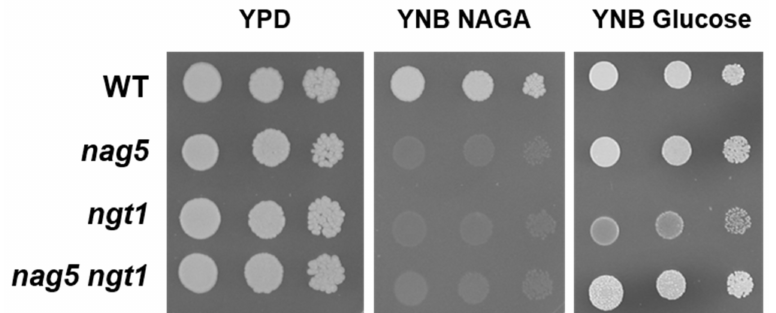
Figure 2. Growth behaviour of Y. lipolytica strains bearing disruptions in YlNAG5 and YlNGT1 . Seven microlitres of suspensions of about 10 6 cells/mL and successive 10-fold dilutions of each strain were plated. They were grown in the indicated media at 30 ◦ C. Pictures were taken after three days of